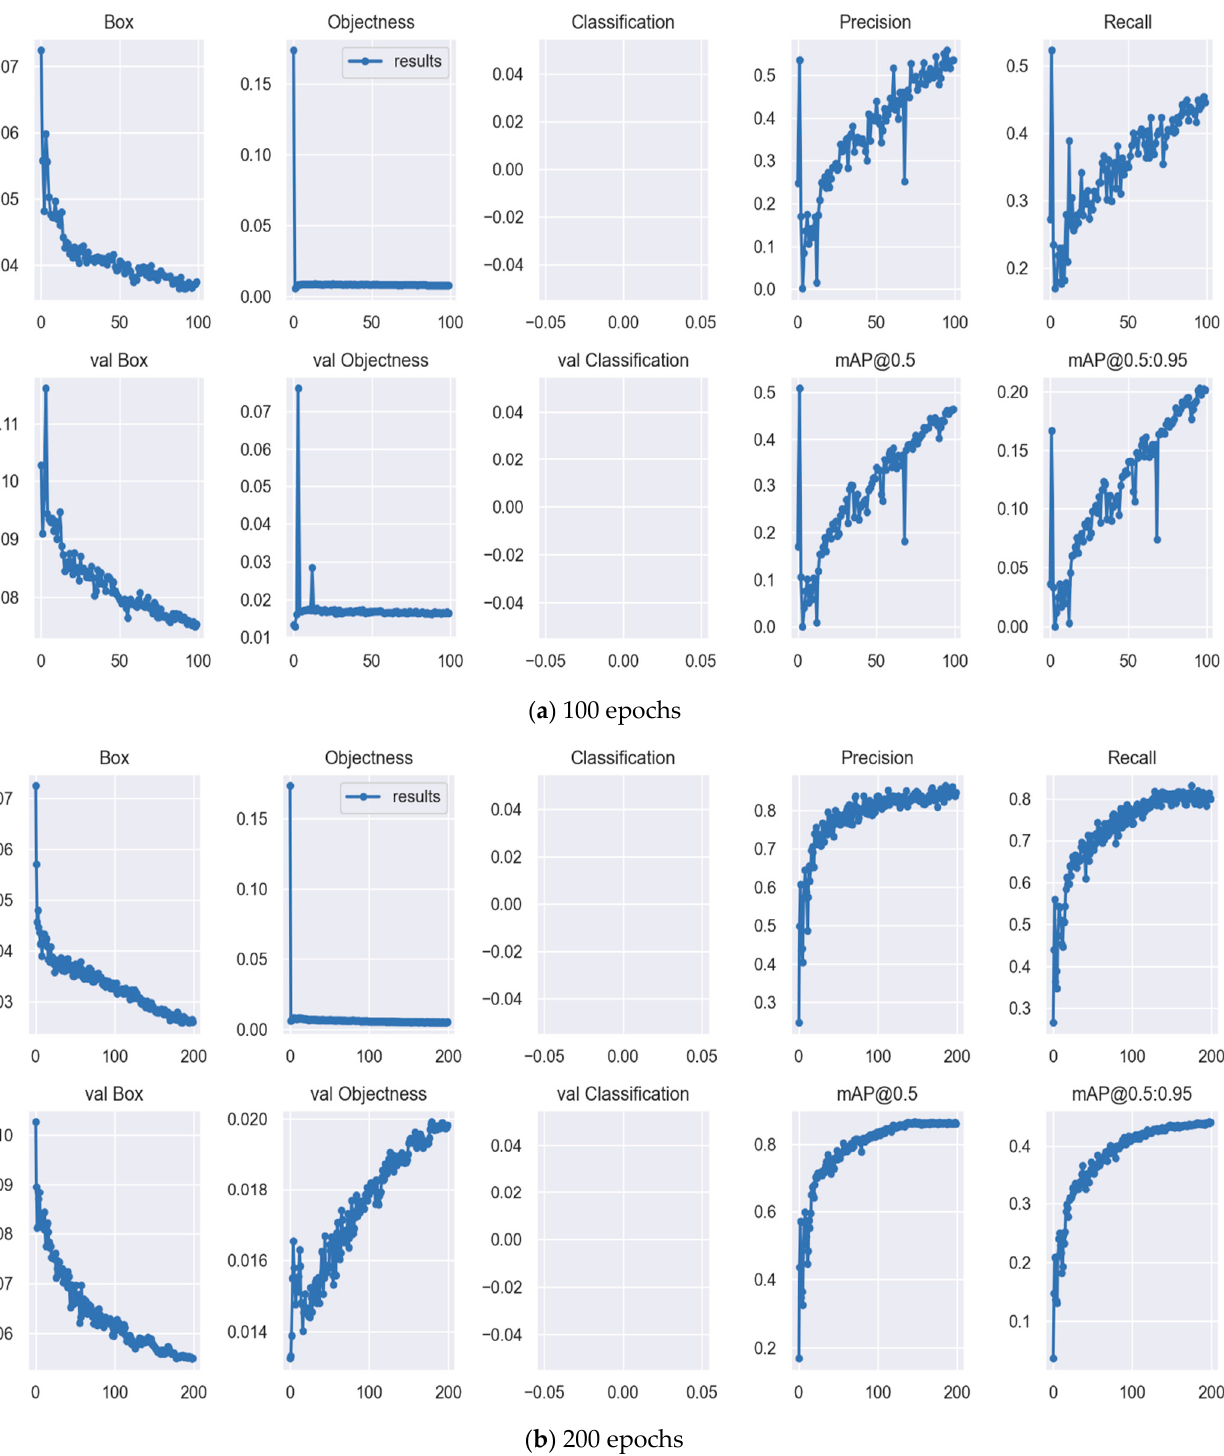
( b ) 200 epochs Figure 6. Precision and recall of Yolov7x with ( a ) 100 and ( b ) 200 epochs.